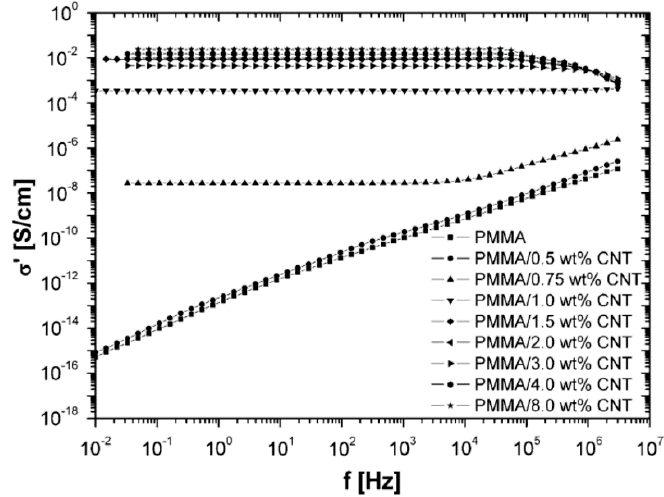
Figure 6. Variation of the real part of conductivity with frequency for MWCNT/PMMA composite with varying amounts of MWCNT at room temperature [3].